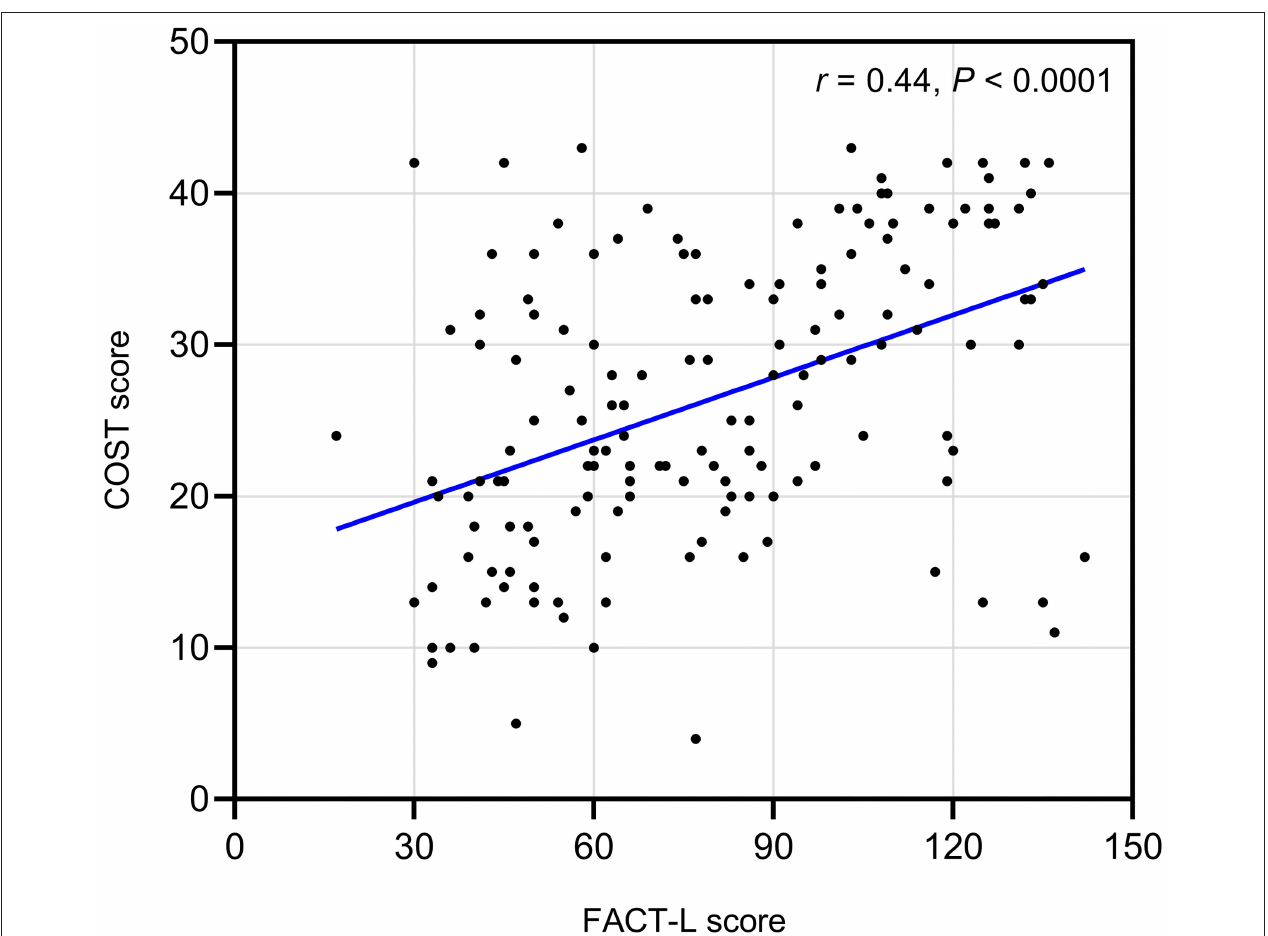
FIGURE 2 | Correlation between financial toxicity and health-related quality of life. Increased financial toxicity (lower COST) is moderately associated with decreased quality of life (lower FACT-L). Pearson correlation coefficient :0.4 4, P <